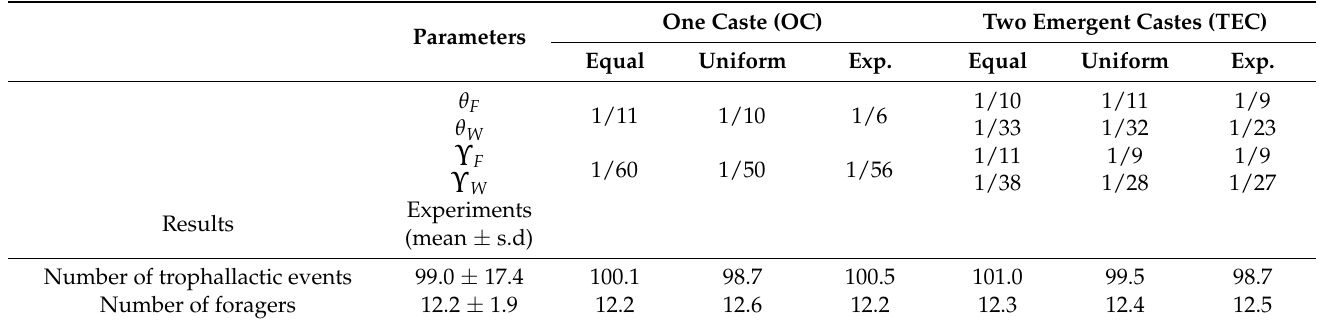
Table 1. The upper part of the table shows the parameter values of the two versions of the model and three distributions. Only the parameters that vary between models are shown. The lower part of the table shows the main experimental and theoretical results of the foraging activity. See the text for further explanation. One Caste (OC) Two Emergent Castes Parameters